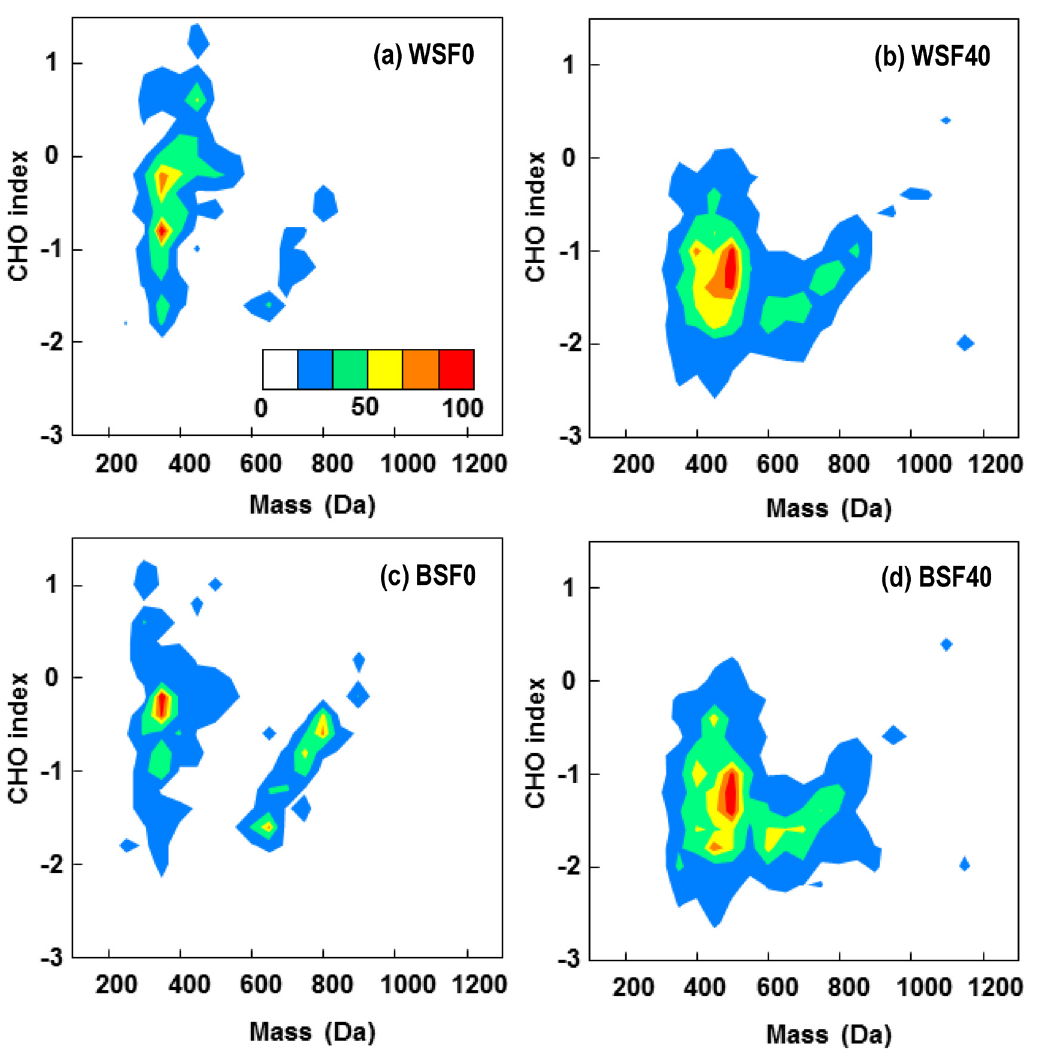
Fig 4. Heatmaps for CHO index as a function of molecular mass of extracted SOM compounds before and after the soil warming experiment. The color bar represents the relative abundance of compounds identified in each of the SOM extract: (a) WSF0, (b) WSF40, (c) BSF0, and (d) BSF40. A positive correlation between CHO index and mass can be observed for mass > 600